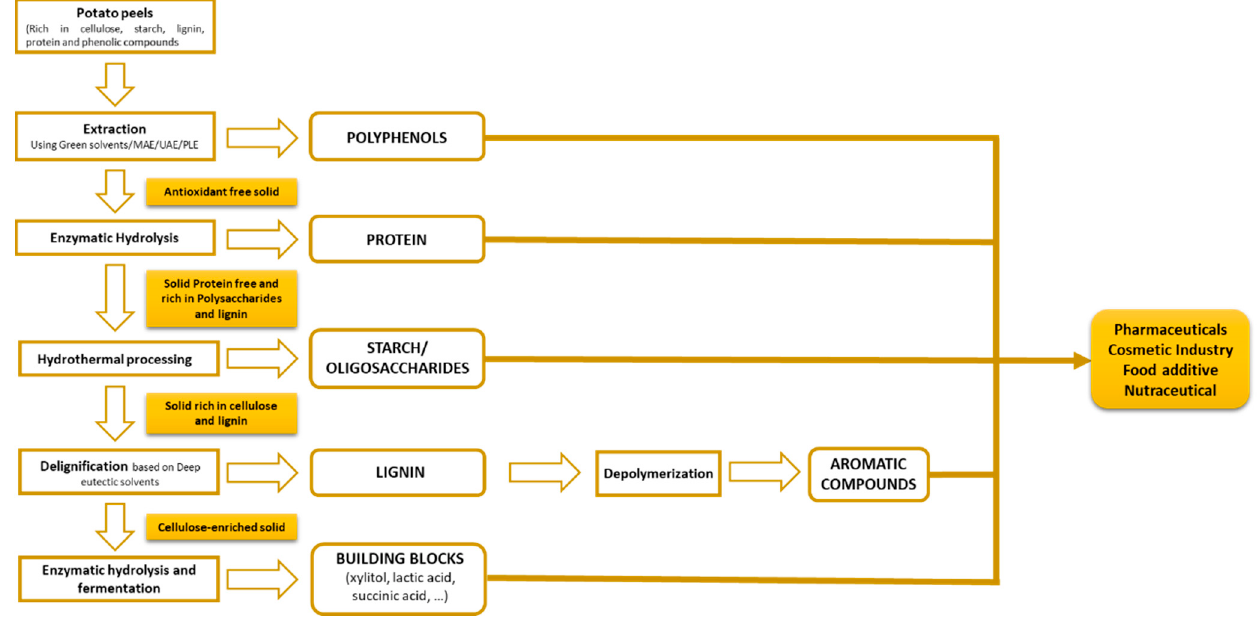
Figure 4. Integrated biorefinery model for potato peel waste.